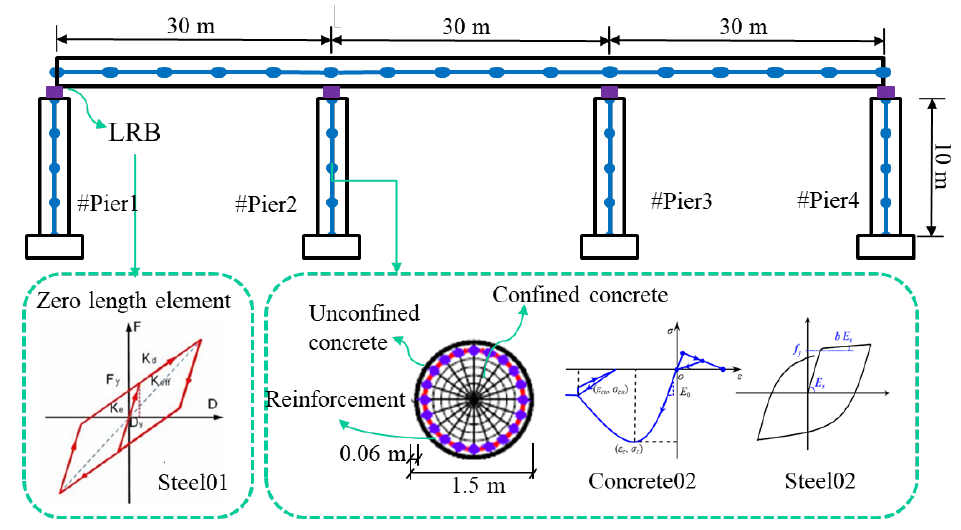
Figure 2. Nonlinear finite element model of the continuous girder bridge finite element model.